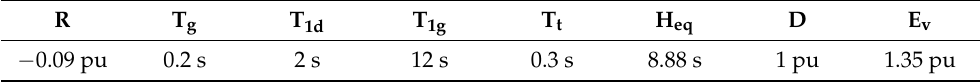
Table 2. Parameters for the simplified model of the power